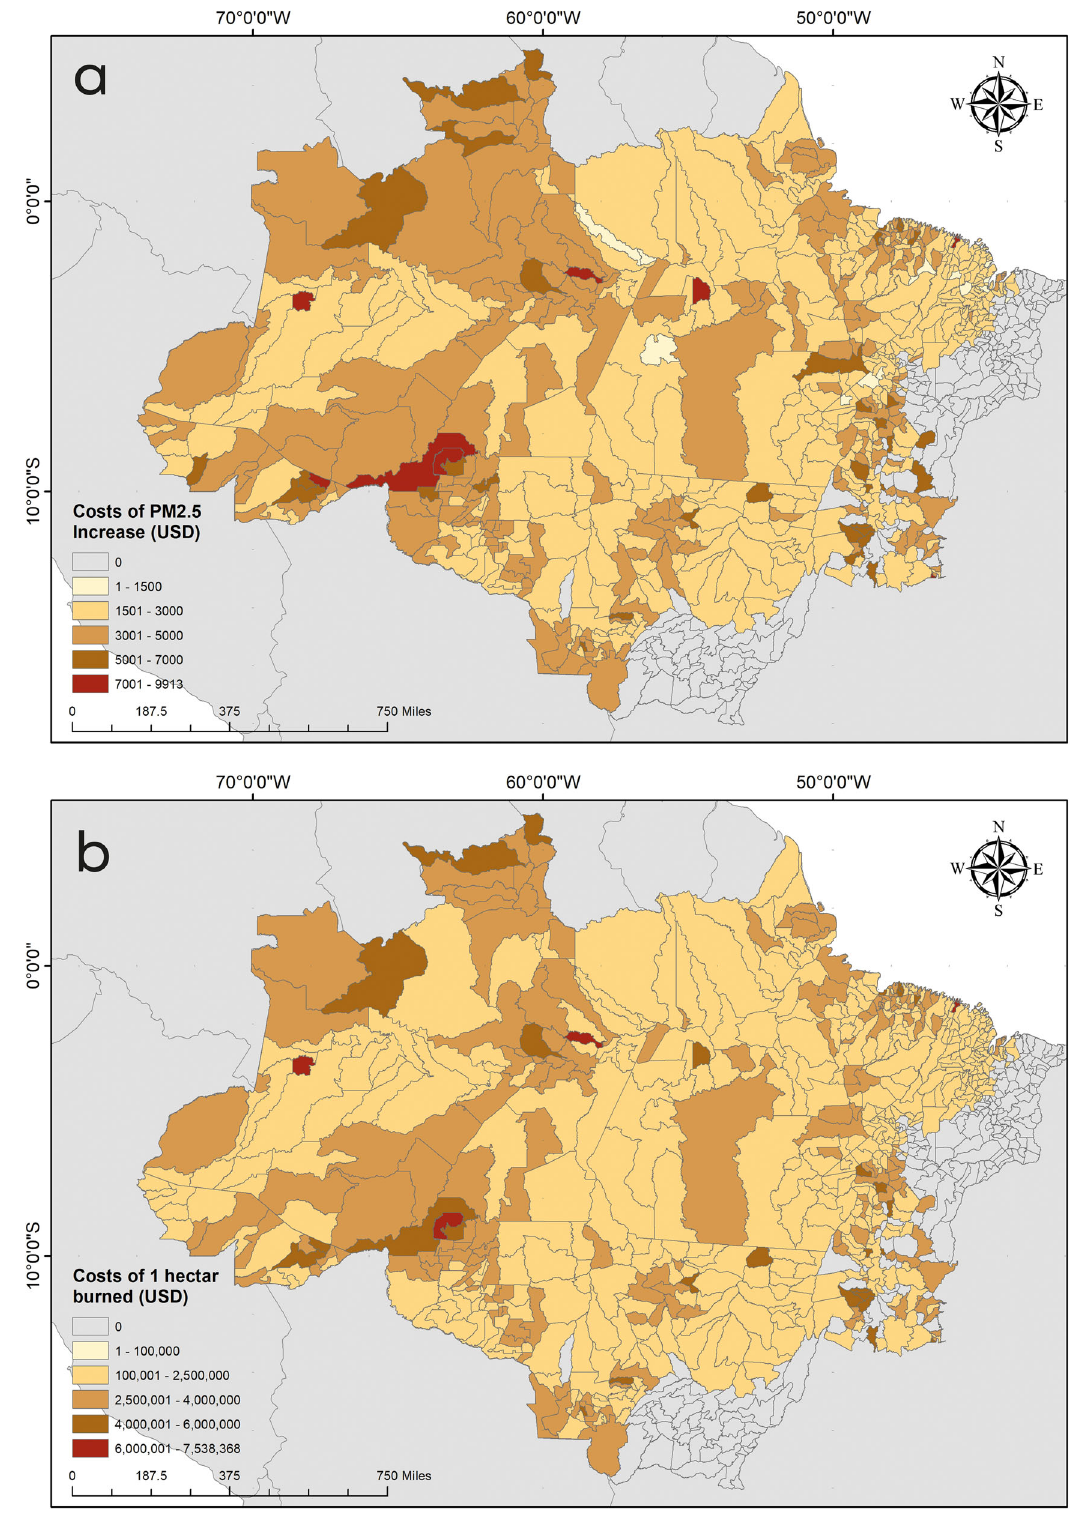
Fig. 5 Economic costs of forest fi res. Economic costs associated with the increase of ( a ) 1 kg of PM 2.5 and ( b ) one hectare of Amazon burned, in USD.